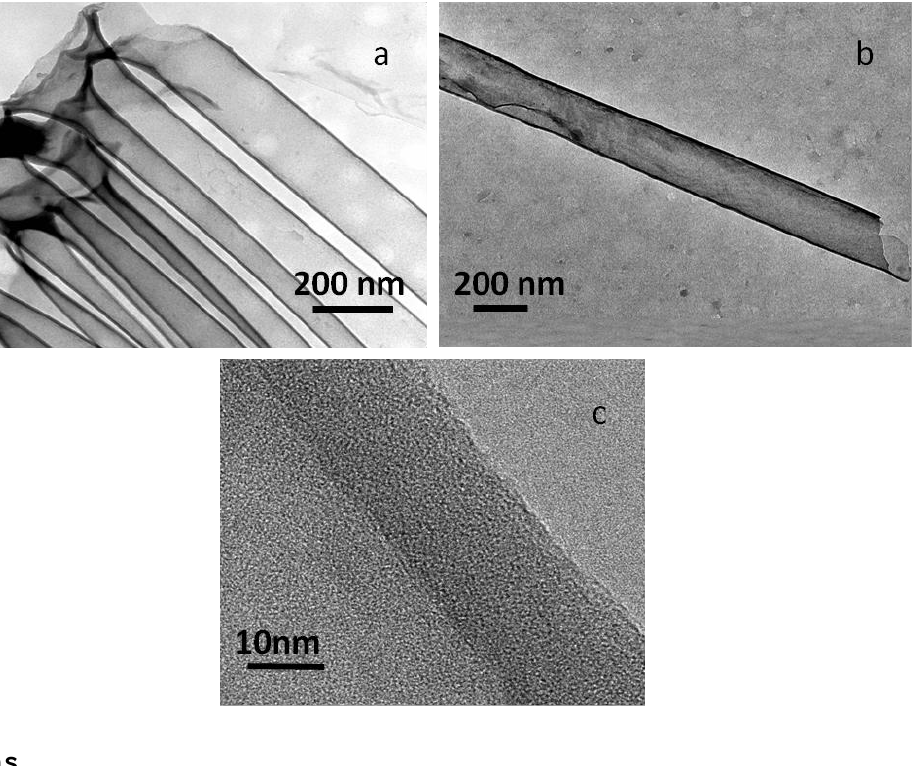
Figure 6. TEM ( a , b ) and HRTEM ( c ) images of